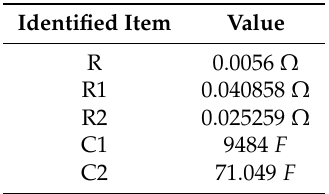
Table 6. Battery parameters’